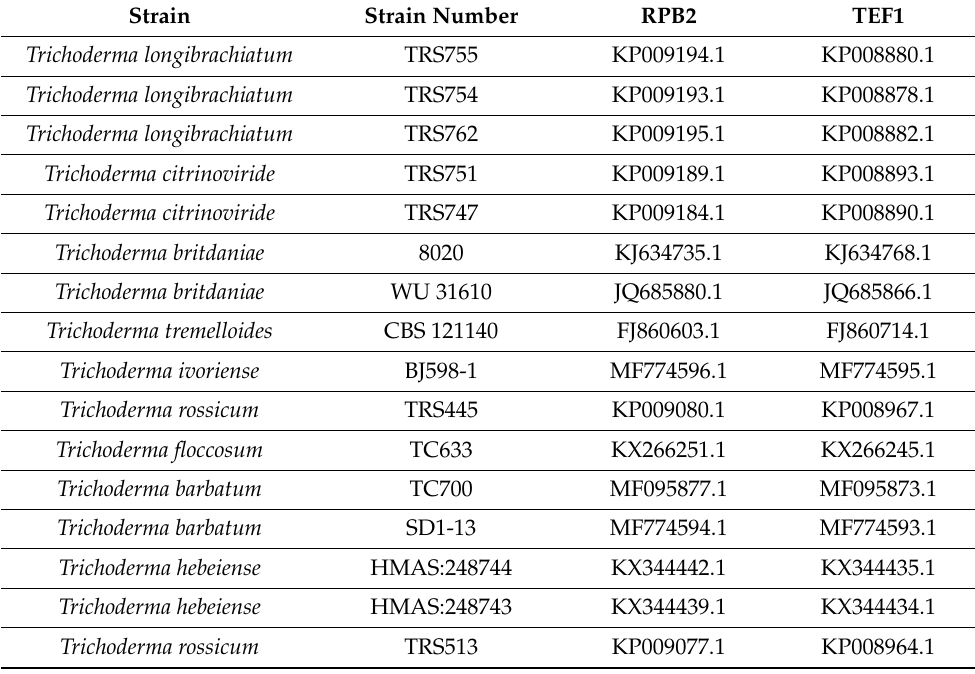
Table 1. The strains used to construct the phylogenetic tree.